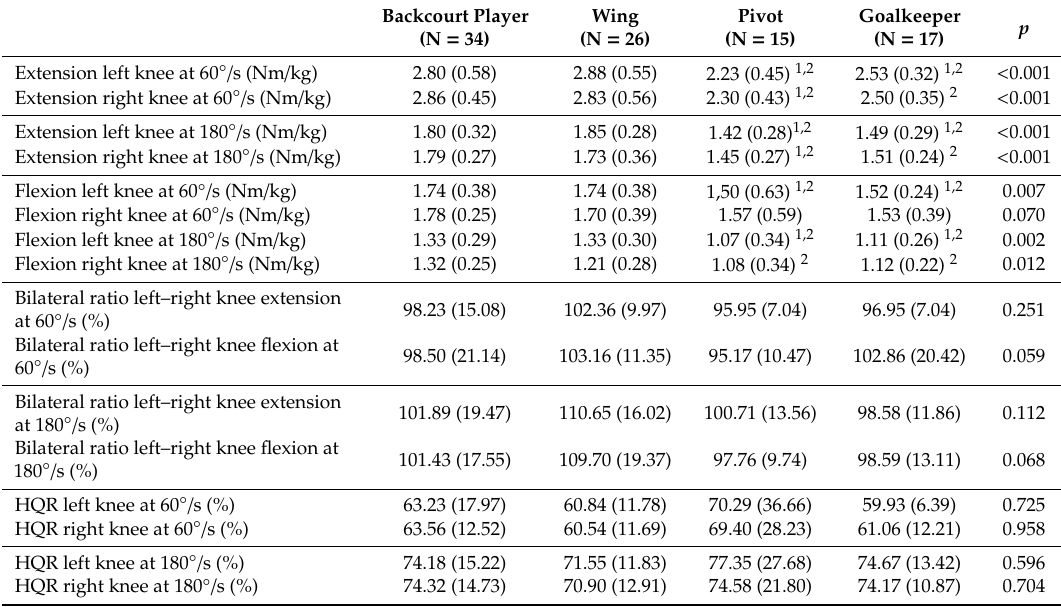
Table 2. Di ff erences among playing positions in isokinetic concentric torque. Backcourt Player (N =